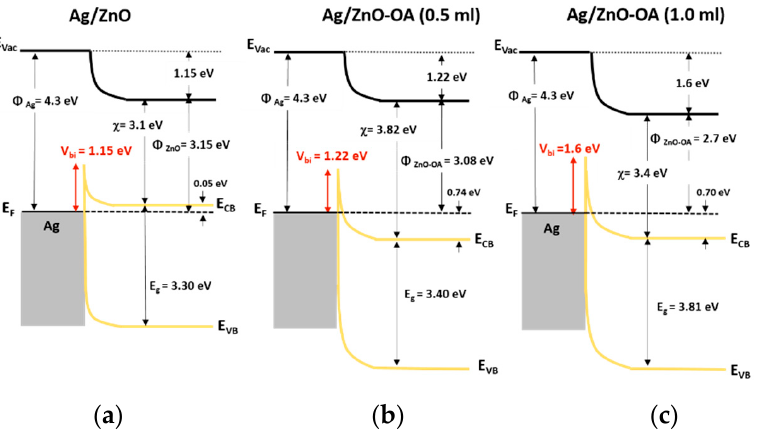
Figure 11. Induced built-in potential ( V bi ) at the interface of ( a ) Ag/ZnO QDs, ( b ) Ag/ZnO-OA (0.5 mL) QDs, and ( c ) Ag/ZnO-OA (1.0 mL) QDs.